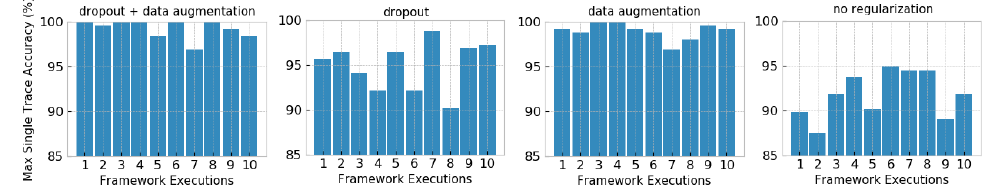
Figure 22: Fixed CNN hyperparameters: maximum single trace accuracy on the cswap- pointer dataset for ten different framework executions and attacking the sample interval range from 550 to 800 of all sub-traces.